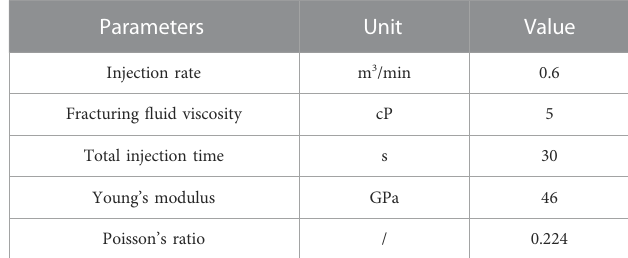
TABLE 1 The input parameters for hydraulic fracturing